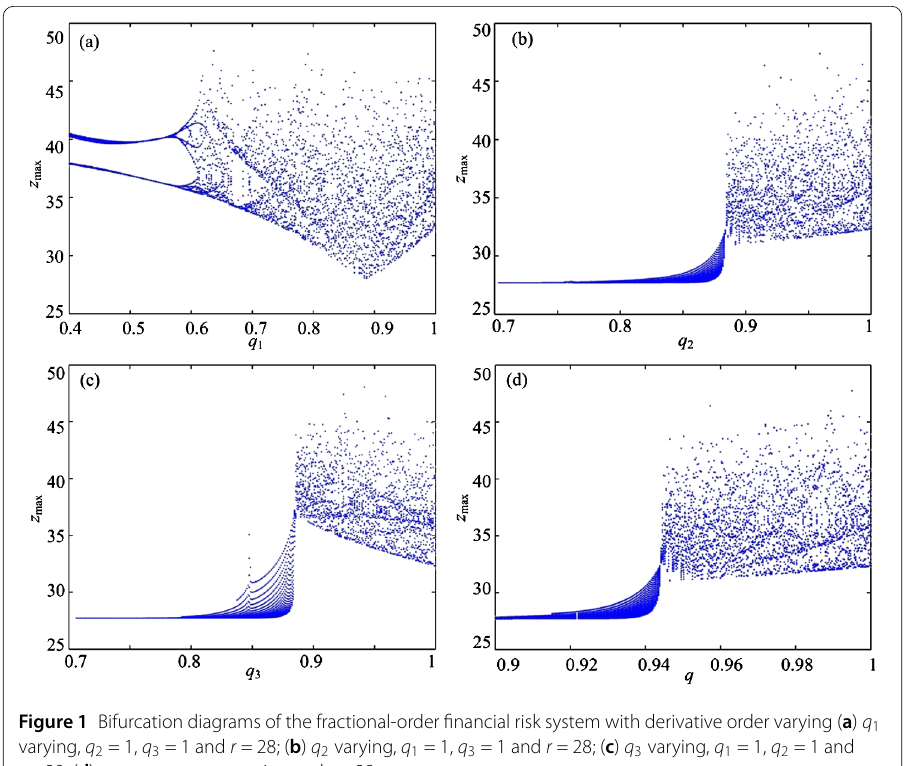
Figure 1 Bifurcation diagrams of the fractional-order financial risk system with derivative order varying ( a ) q 1 varying, q 2 = 1, q 3 = 1 and r = 28; ( b ) q 2 varying, q 1 = 1, q 3 = 1 and r = 28; ( c ) q 3 varying, q 1 = 1, q 2 = 1 and r = 28; ( d ) q